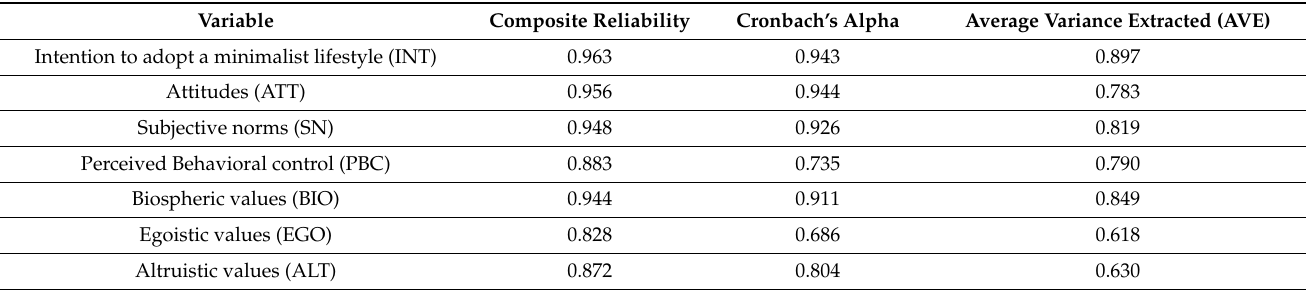
Table 2. The reliability of measurement.